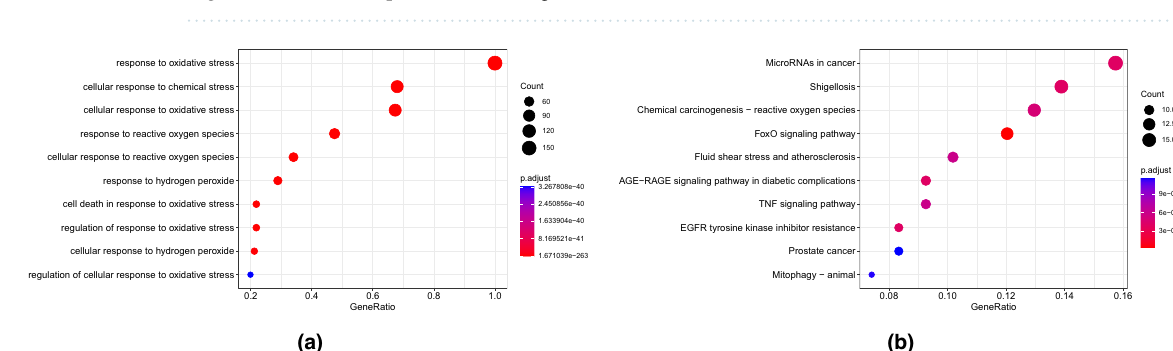
Figure 9. Manhattan plot of candidate genes.